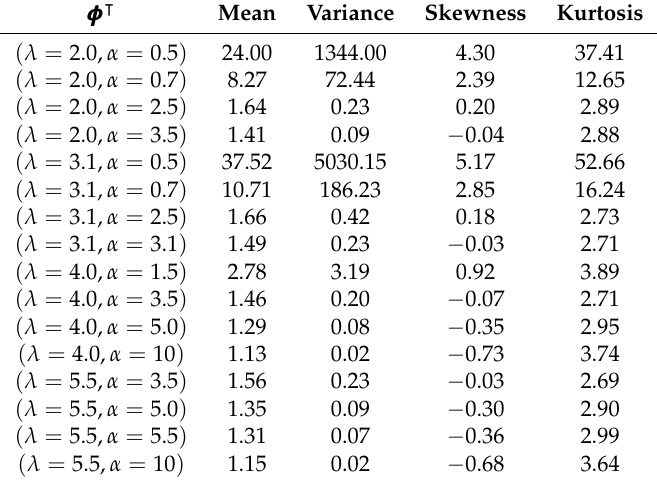
Table 1. Mean, variance, skewness, and kurtosis of the GRL distribution for different values of the parameters λ and α . φφφ (cid:124) Mean Variance